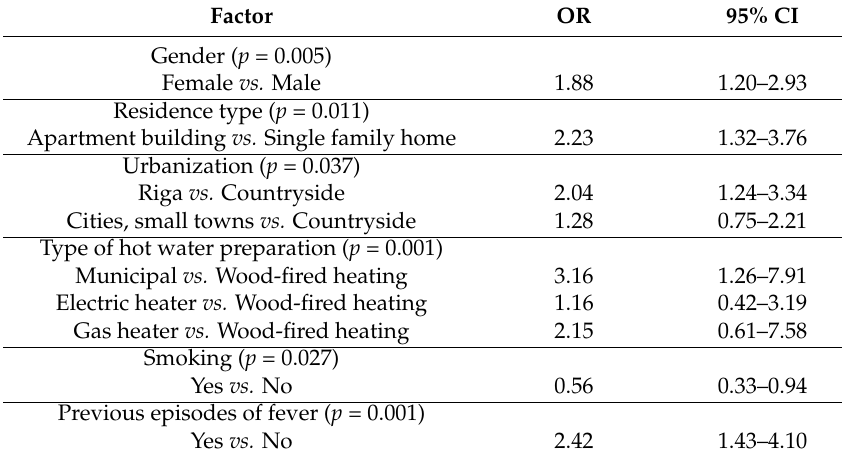
Table 2. Odds ratios and 95% CI for association between Legionella pneumophila SG 1–6 seropositivity and relevant